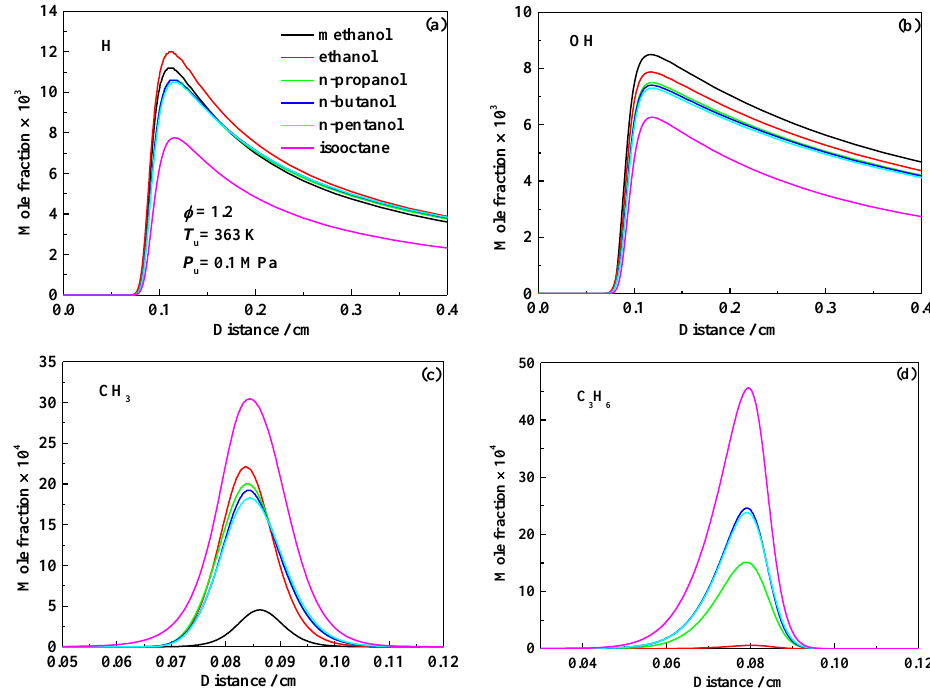
Figure 9. Mole fraction profiles of key species for pure isooctane and alcohol fuels at 363 K, 0.1 MPa and equivalence ratio of 1.2: ( a ) H; ( b ) OH; ( c ) CH 3 ; and ( d ) C 3 H 6 .